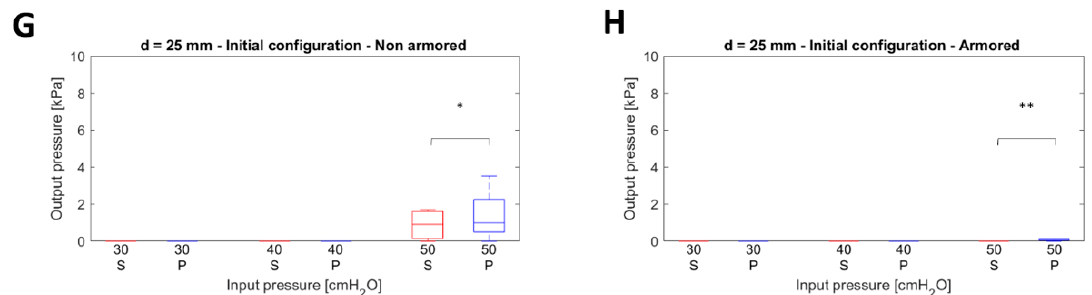
Figure 4. Statistical analysis to determine the differences in pressure, if any, before performing a maneuver. ( A – D ) Box plots showing the comparison between non-armored (NA) and armored (A) tubes across diameters of the trachea and position (S—supine, P—prone). ( E – H ) Box plots showing the comparison between body position (S/P) against diameters and type of endotracheal tube (NA/A). Legend: ** p < 0.001, * 0.002 < p ≤ 0.05, and + p > 0.05.